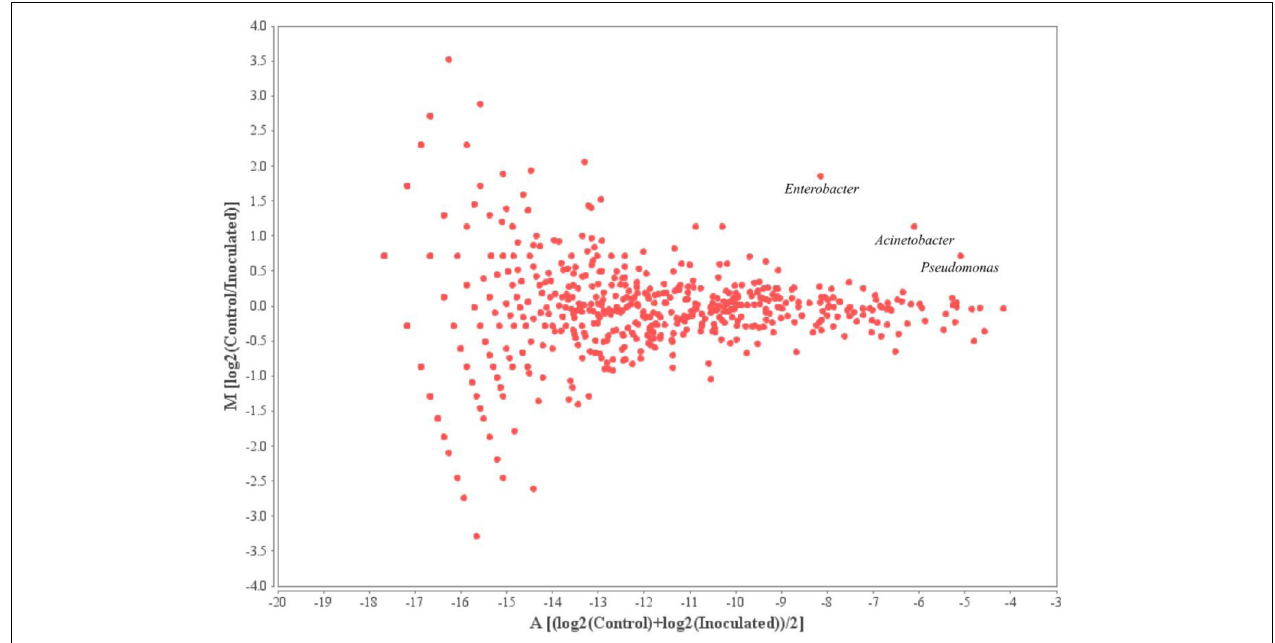
FIGURE 8 | MA-Plot visualizing the values of annotated genera within the t1 samples. Log2(Control/Inoculated) indicates the fold-changes in the abundances of annotated genera between the two samples; (log2(Control) + log2(Inoculated))/2 shows the average abundance of an annotated genus.